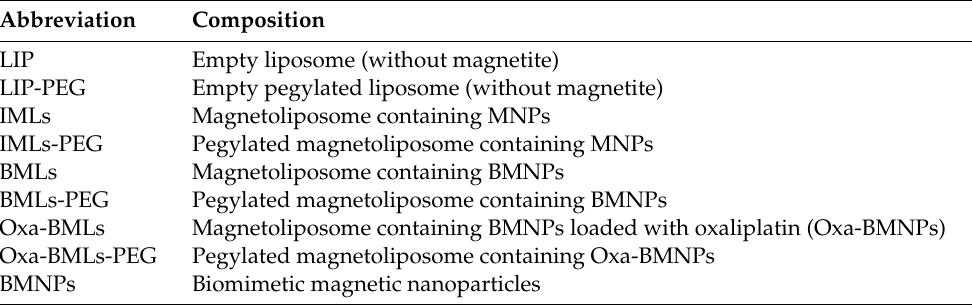
Table 1. Synthetized